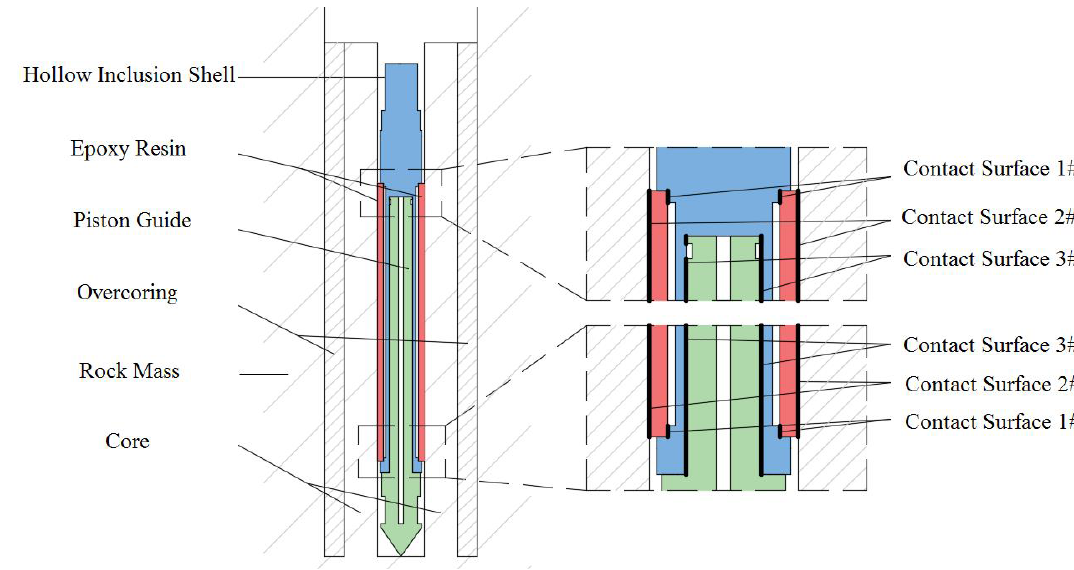
Figure 15. Assembly and contact surface setting diagram of each part of the CAE module.